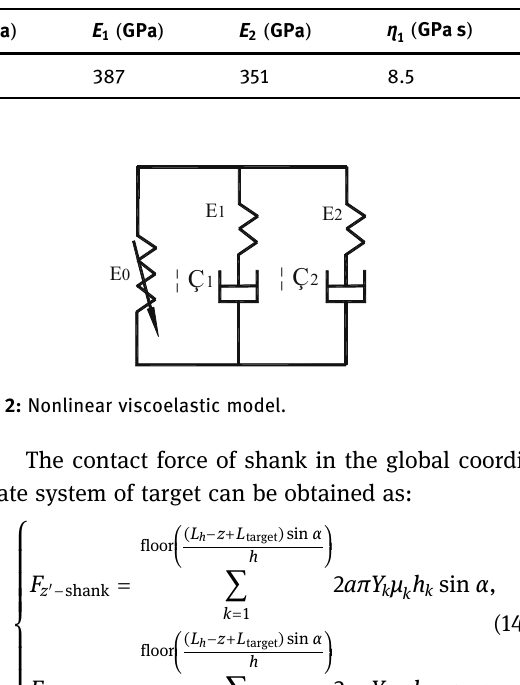
Table 1: Viscoelastic properties of Kevlar/epoxy